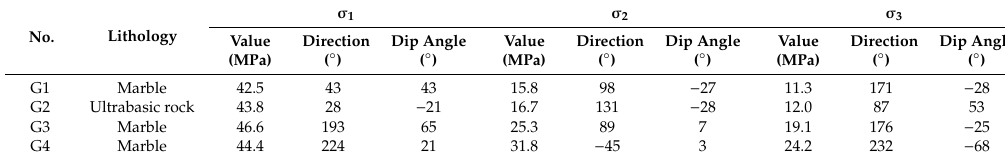
Table 1. Mechanical and physical parameters of rocks and rock masses.